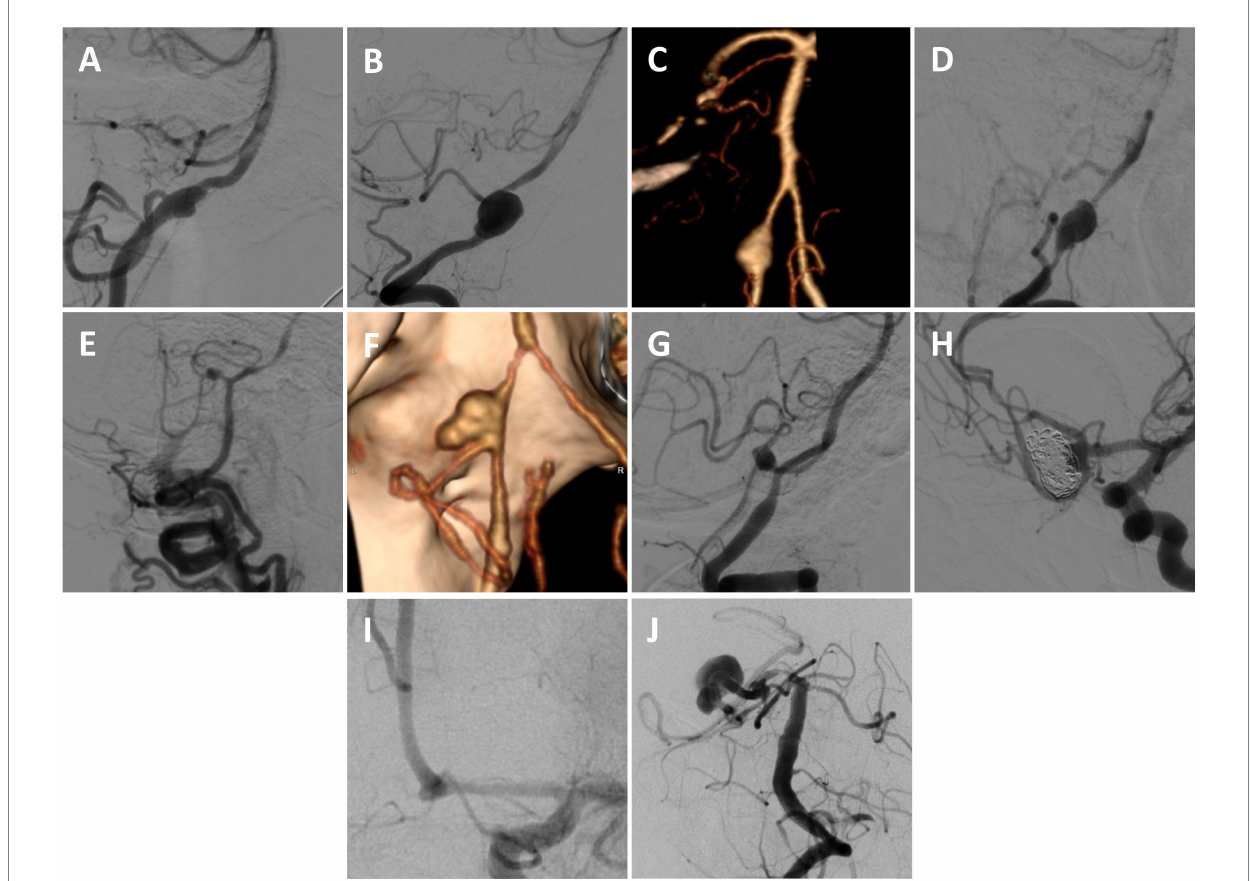
FIGURE 1 Treated aneurysms. (A) Left VA fusiform ruptured aneurysm involving the proximal left PICA (lateral angiogram of left VA). (B) Right VA fusiform ruptured aneurysm involving the proximal right PICA (lateral angiogram of the right VA). (C) Left VA fusiform ruptured aneurysm involving the proximal left PICA (3D-reconstruction). (D) Right VA fusiform ruptured aneurysm involving the proximal right PICA (lateral angiogram of the right VA). (E) Right proximal AICA/PICA fusiform ruptured aneurysm involving the vessel origin (lateral angiogram of the right VA, also demonstrating an iatrogenic right cervical VA-venous fistula from an unsuccessful prior endovascular treatment attempt). (F) Left VA fusiform ruptured aneurysm involving the proximal left PICA (3D-reconstruction). (G) Left proximal PICA fusiform ruptured aneurysm (lateral angiogram of left VA). (H) Recurrent ruptured and partially coiled Acomm aneurysm arising from an azygous left A1 (oblique angiogram of the left ICA). (I) Left A1-2 junction traumatic ruptured pseudoaneurysm (oblique angiogram of the left ICA). (J) Large right fusiform P2 aneurysm with a proximal dysplastic P1 (AP angiogram of the left